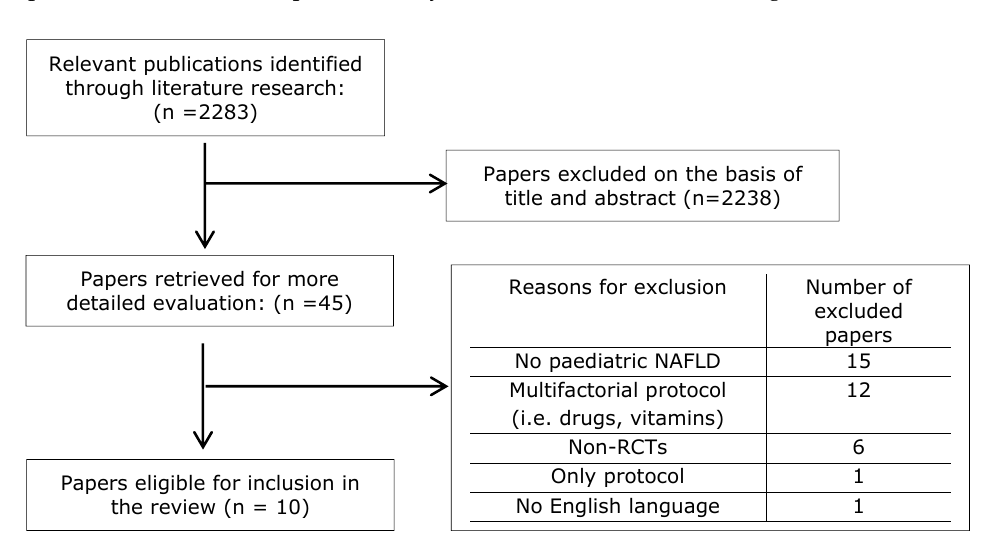
Figure 1. Flowchart of the included studies.